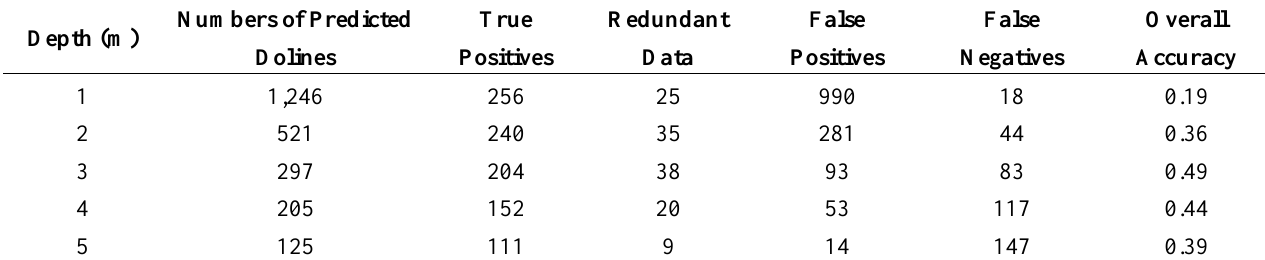
Table 1. Dolines predicted from SRTM-DEM data using different threshold values for sink depth. The comparison is made with 249 true dolines obtained by visual